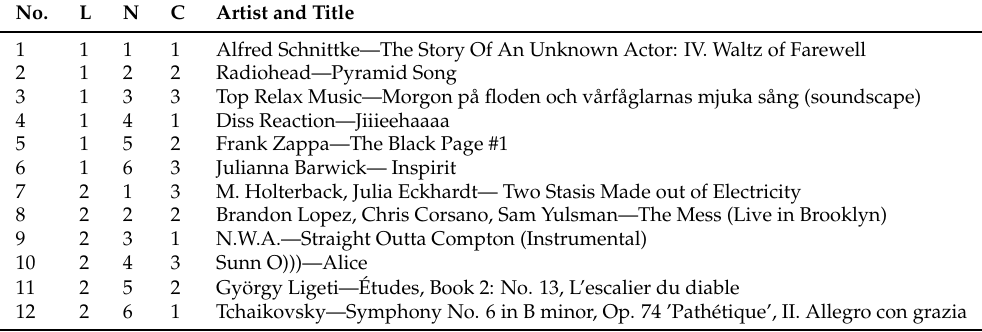
Table 1. Playlists used during the music listening sessions. The following abbreviations are used: L = playlist number, N = number in sequence, C = category, referring to (1) music with clear rhythmic structure, (2) music with more complex rhythmic structure, and (3) music with the absence of a clear rhythmic